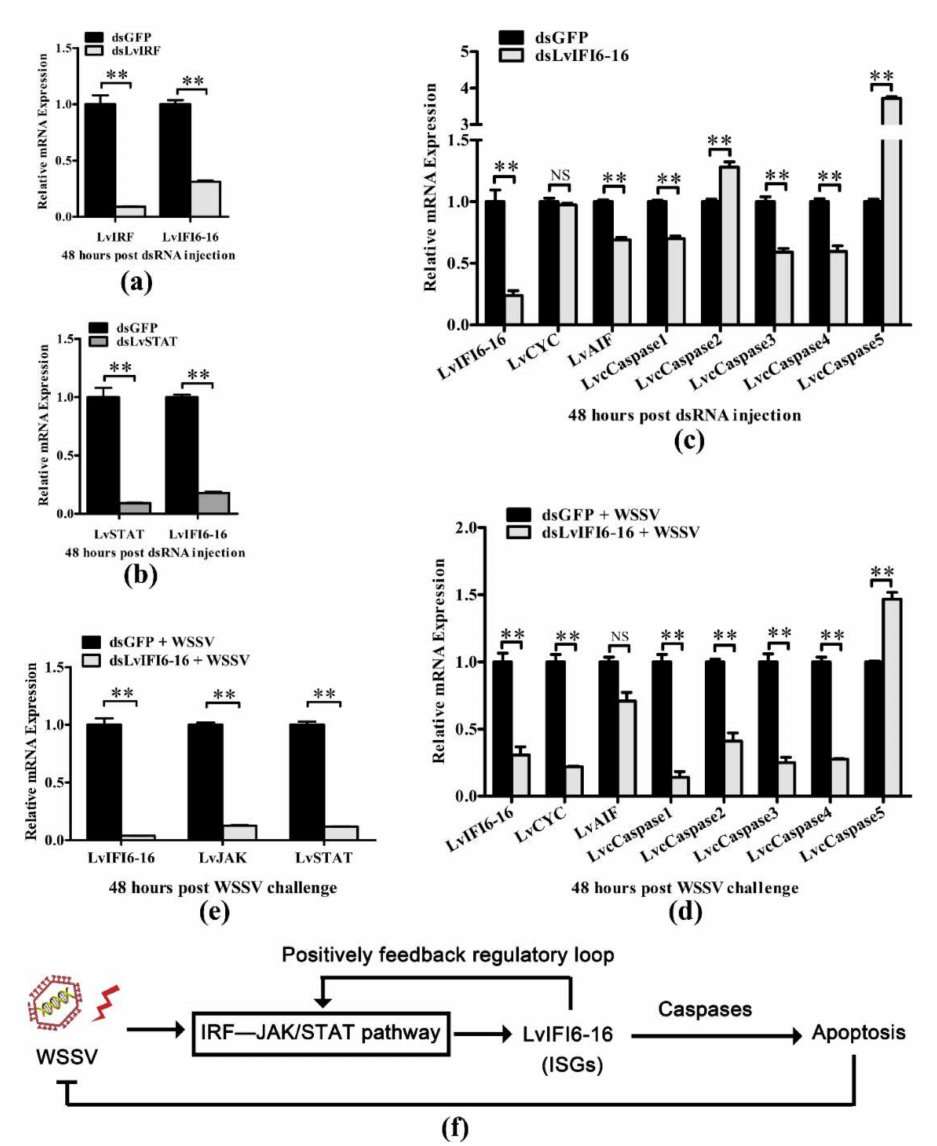
Figure 5. The regulatory effects between LvIFI6-16 and LvIRF, LvJAK, LvSTAT, or apoptosis-related genes before and after WSSV infection. ( a ) The transcription level of LvIFI6-16 in gills was regulated by LvIRF. ( b ) The transcription level of LvIFI6-16 in gills was regulated by LvSTAT. The internal control was LvEF-1 α . Samples were taken at 48 h after dsLvIRF, dsLvSTAT, and dsGFP (as a control) injection. Bars indicated the mean ± SD of three samples and statistical significances were calculated by the Student’s t -test (** p < 0.01). ( c ) Transcription levels of apoptosis-related genes in gills of LvIFI6-16-knockdown shrimps. The internal control was LvEF-1 α . Samples were taken at 48 h after injection with indicated dsRNA. Bars indicated the mean ± SD of three samples and statistical significances were calculated by the Student’s t -test (** p < 0.01; NS, not significant). ( d ) Transcription levels of apoptosis-related genes in gills of LvIFI6-16-knockdown shrimps after WSSV challenge. The internal control was LvEF-1 α . Shrimps were injected with dsRNA of LvIFI6-16; after that, shrimp were infected with WSSV and samples were taken 48 h after WSSV infection. Bars indicated the mean ± SD of three samples and statistical significances were calculated by the Student’s t -test (** p < 0.01; NS, not significant). ( e ) LvIFI6-16 regulated the expression of LvJAK and LvSTAT in gills during WSSV infection. Samples were taken as described to ( d ). ( f ) A possible model of the LvIFI6-16